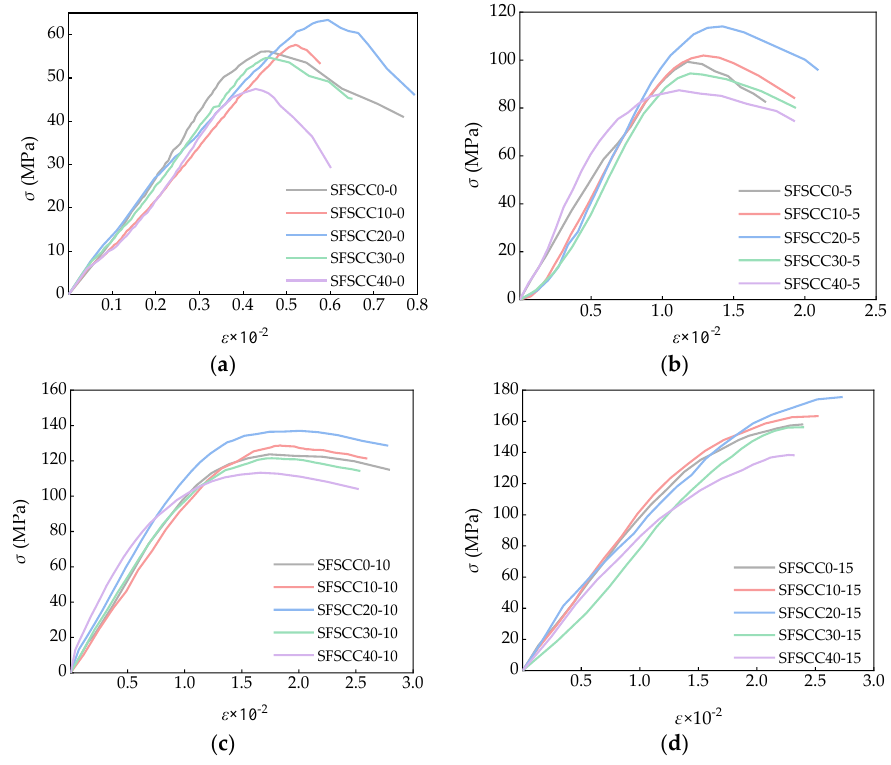
Figure 11. Stress-strain curve of part specimens: ( a ) σ 2 = σ 3 = 0 MPa; ( b ) σ 2 = σ 3 = 5 MPa; ( c ) σ 2 = σ 3 = 10 MPa; ( d ) σ 2 = σ 3 = 15 MPa.